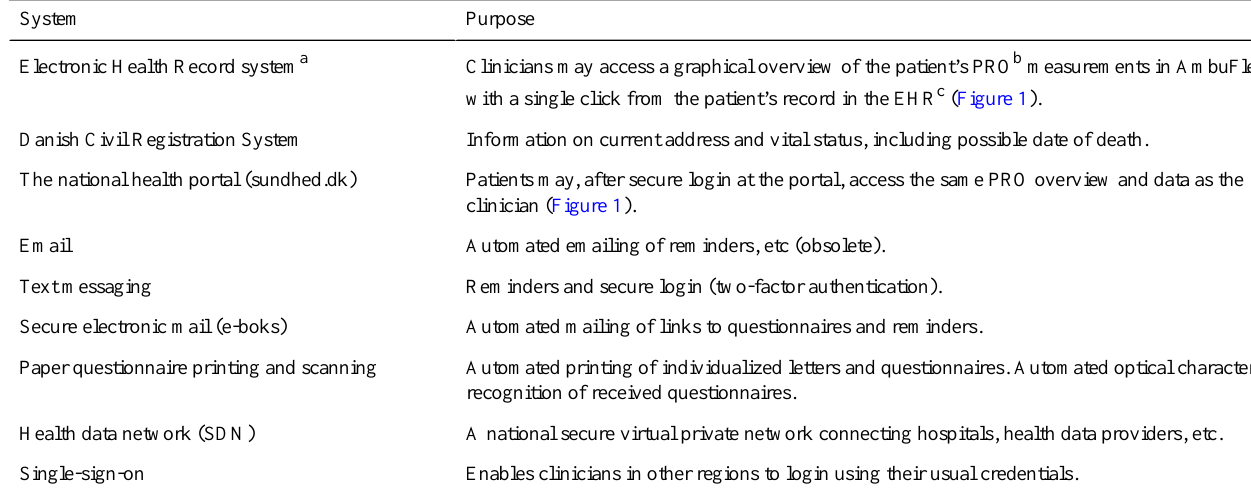
Table 1. The AmbuFlex/WestChronic PRO system’s online integrations with other systems. PurposeSystem